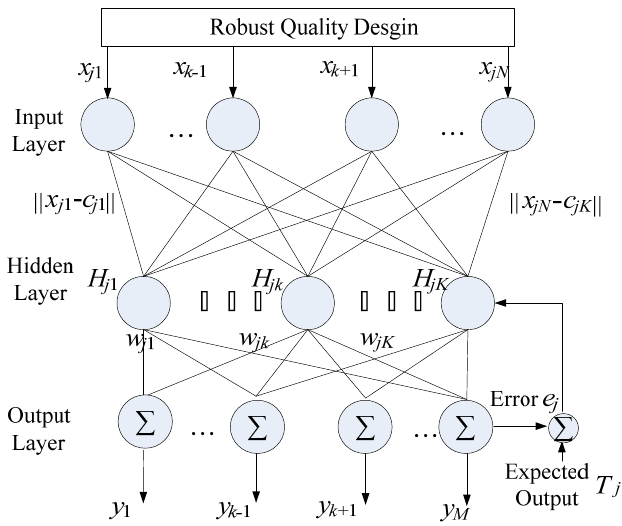
Figure 1. The ERBFN structure.